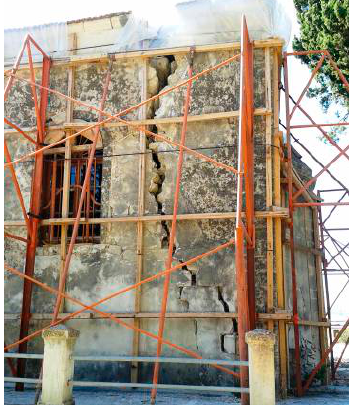
Figure 18. Damage at the N-W corner.